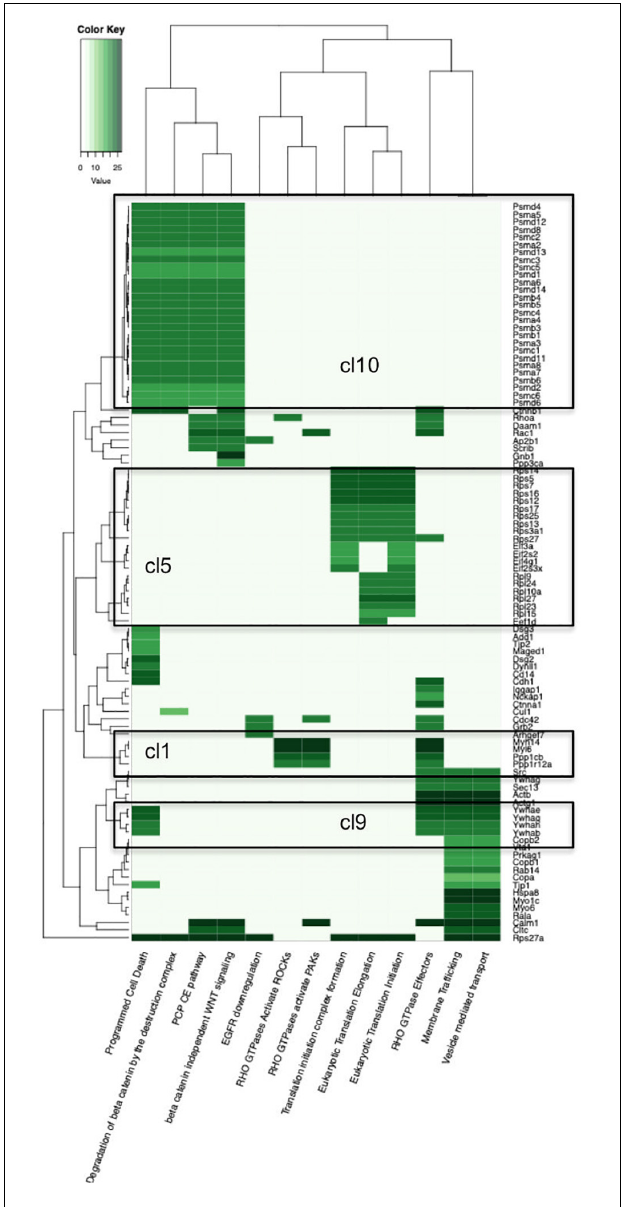
FIGURE 2 | Heatmap of the Reactome Pathway enrichment analysis clustering. Color intensity is based on the average relative protein abundance in MS. Blocks with numbers correspond to respective cluster on the PPI network where this group of proteins